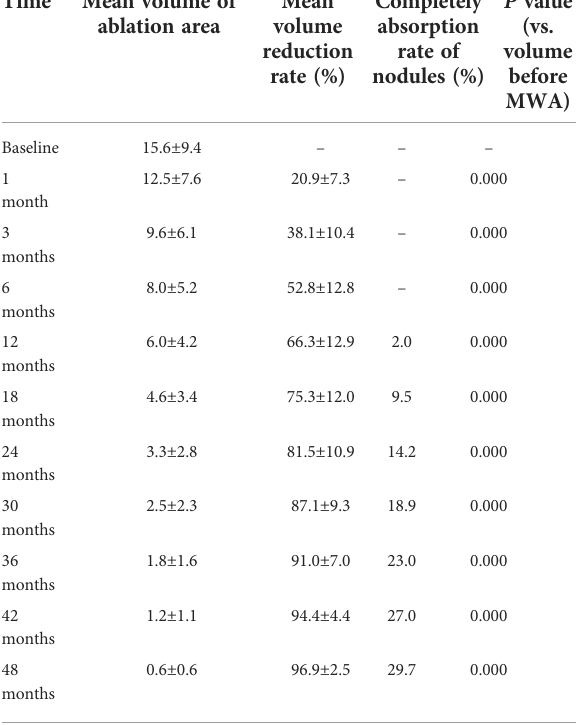
TABLE 2 Mean volume, volume reduction rate and absorption rate of the nodules after MWA.